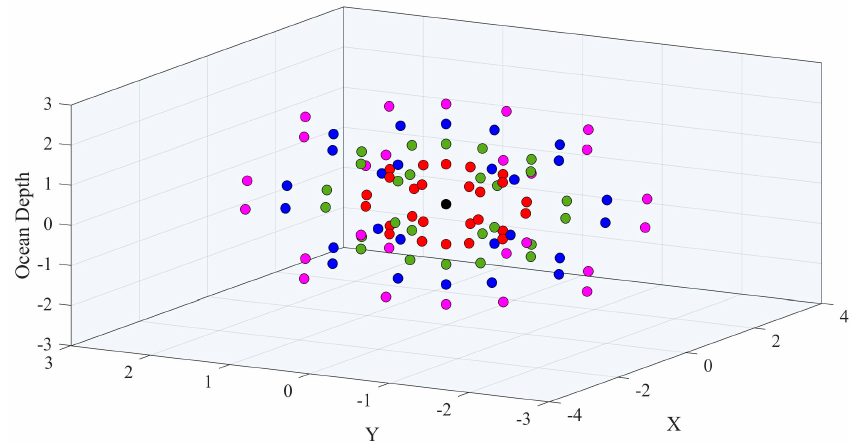
Figure 1. Example of node positions in a 3D spherical Wireless Sensor Network.